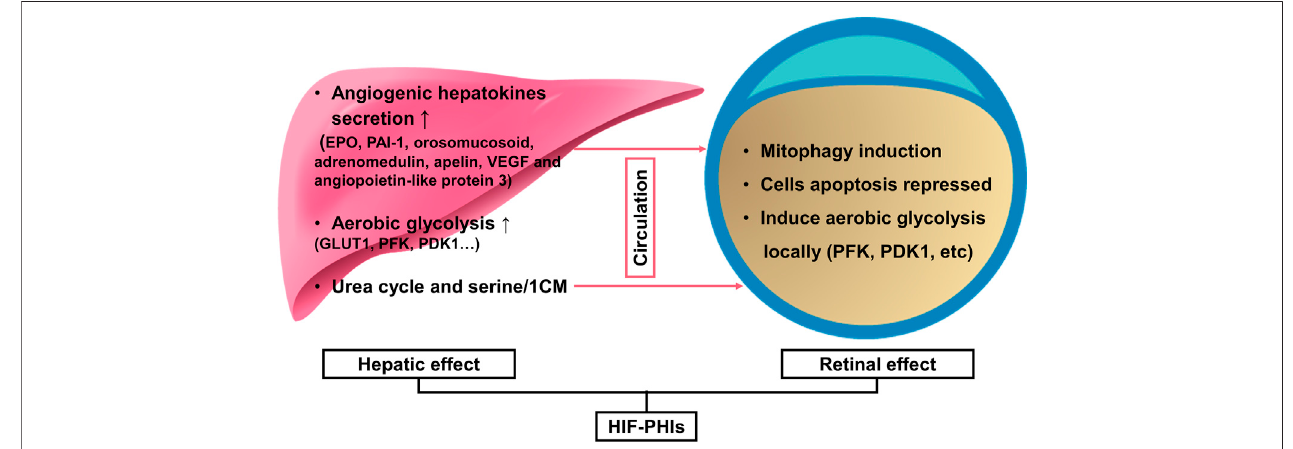
FIGURE2| HIF-PHIsinthe preventionofretinopathy ofprematurityand retinal detachment. Together, liverremoteprotectionand retinal localprotectionmediated the retinal protection effect of HIF-PHIs. On the one hand, systemic administration of HIF-PHIs invokes hepatic stabilization of HIF-1 and secretion of angiogenic hepatokines, such as EPO, PAI-1, orosomucosoid, adrenomedulin, apelin, VEGF and angiopoietin-like protein 3 thereafter. In addition, systemic HIF-PHI treatment dominantly upregulated the urea cycle and serine/1-carbon metabolism in the liver. The upregulated urea cycle and serine/1-carbon metabolism have proangiogenic effects and protect retinal blood vessels, thus emphasizing the importance of the liver in remote protection of the retina. On the other hand, HIF-PHIs enhance selective mitophagy against ROS, reduce cell apoptosis, and induce local aerobic glycolysis, which is reported to drive endothelial growth and repair. Thus, systemic HIF-PHI treatment targeting both the liver and the eye provides a rationale for protecting severe retinopathy of prematurity and retinal detachment. HIF-PHIs, HIF prolyl hydroxylase domain enzyme inhibitors; EPO, erythropoiesis; PAI-1, plasminogen activator inhibitor 1; VEGF, vascular endothelial growth factor; GLUT1, glucose transporter 1; PFK, phosphofructokinase; PDK1, pyruvate dehydrogenase kinase 1; 1CM, 1-carbon